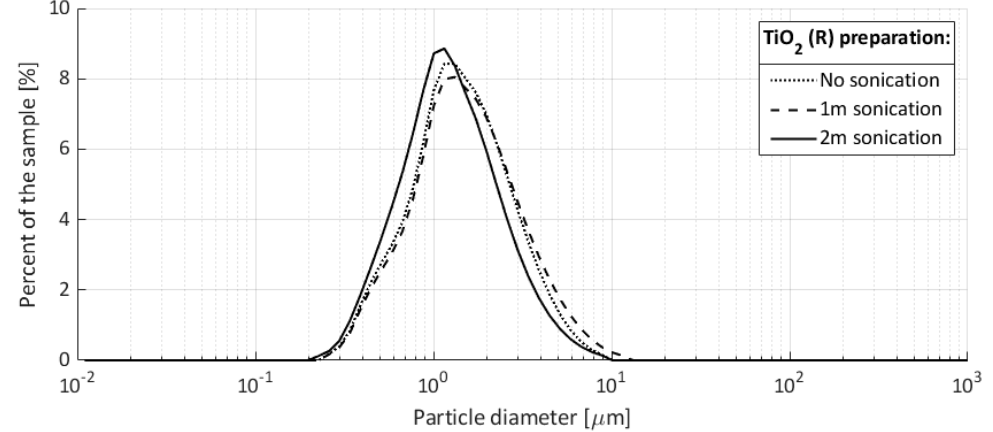
Figure 9. Particle size distribution for the prepared samples of rutile titania. Mean particle size for the prepared samples were 1.62, 1.78, and 1.42 μ m, which corresponded to not sonicated, sonicated for 1 min, and sonicated for 2 min, respectively.